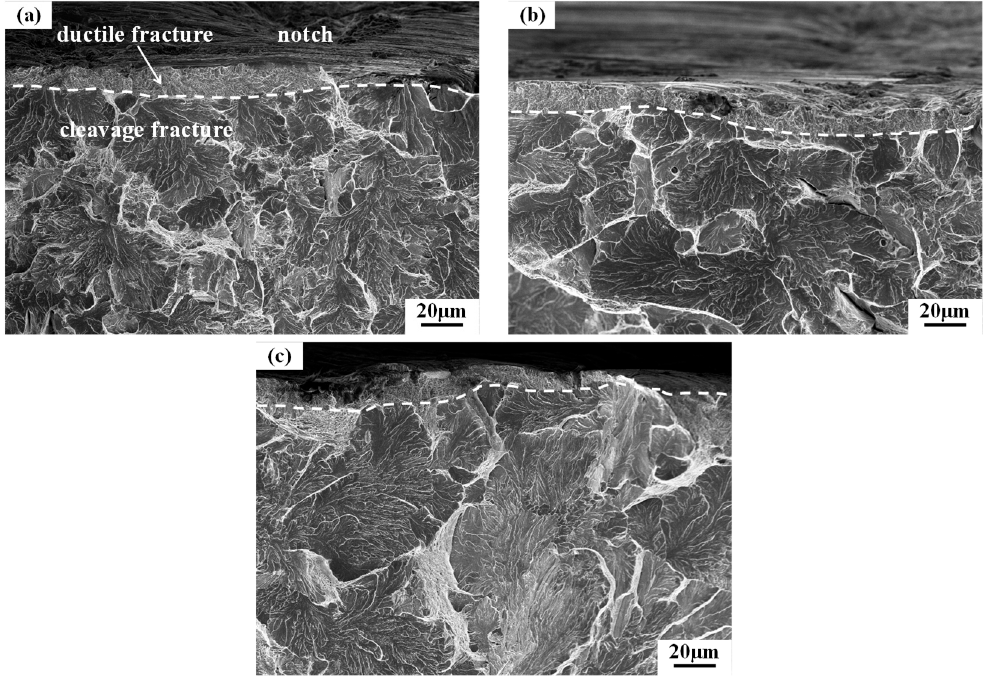
Figure 5. Fracture morphology of impact notch at different austenitizing temperatures: ( a ) 880 °C; ( b ) 1020 °C; and ( c ) 1200 °C.